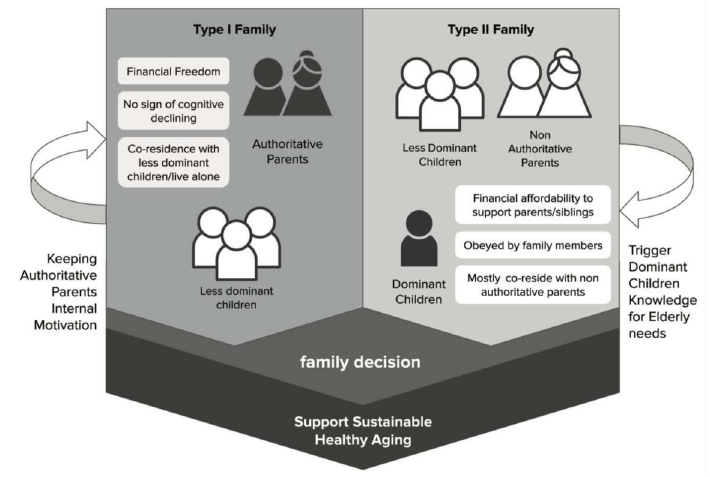
Figure 1. Communication model to support sustainable healthy elderly in intergenerational interac-